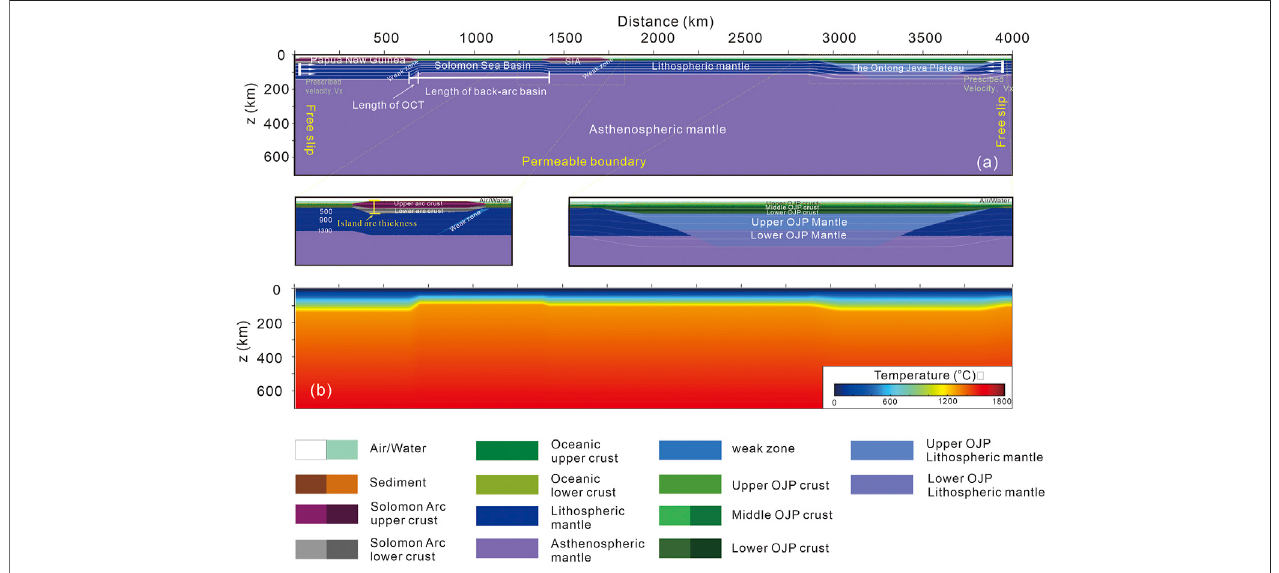
FIGURE 2 | Initial model con fi guration and boundary conditions. Panel (A) shows initial model con fi guration. Panel (B) shows the temperature fi eld. The left inset representsazoomed-inimageoftheislandarc.TherightinsetrepresentsanenlargementoftheOJP.Theisotherms(whitelines)startat100 ° Candareplottedatintervals of 400 ° C. The color key for different materials is shown at the